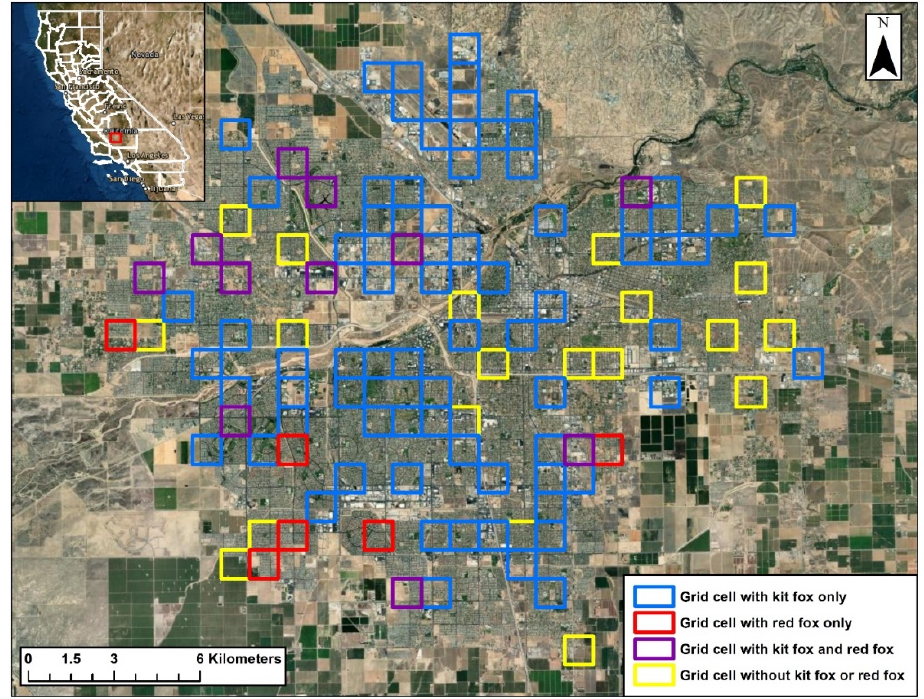
Figure 3. Grid cells in the Bakersfield, California, where San Joaquin kit foxes, red foxes or both species were detected during 2015–2021.